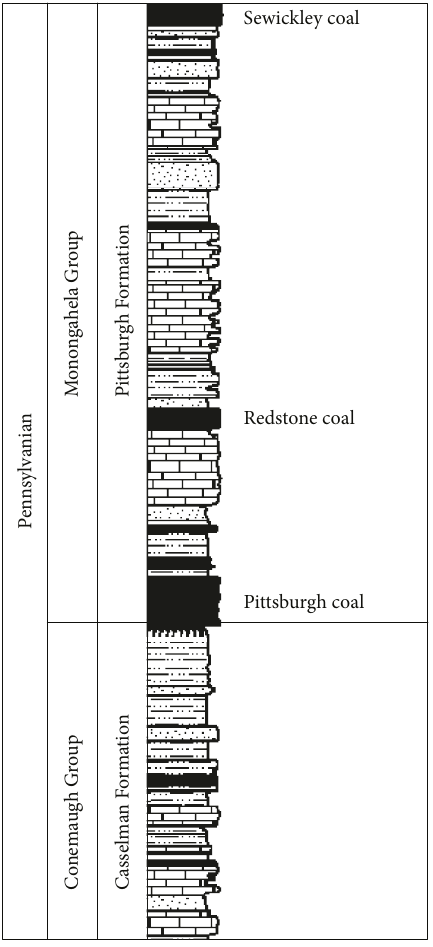
Figure 2: Stratigraphy of Upper Pennsylvanian age coal in the northern Appalachian region, USA. After Cecil et al.